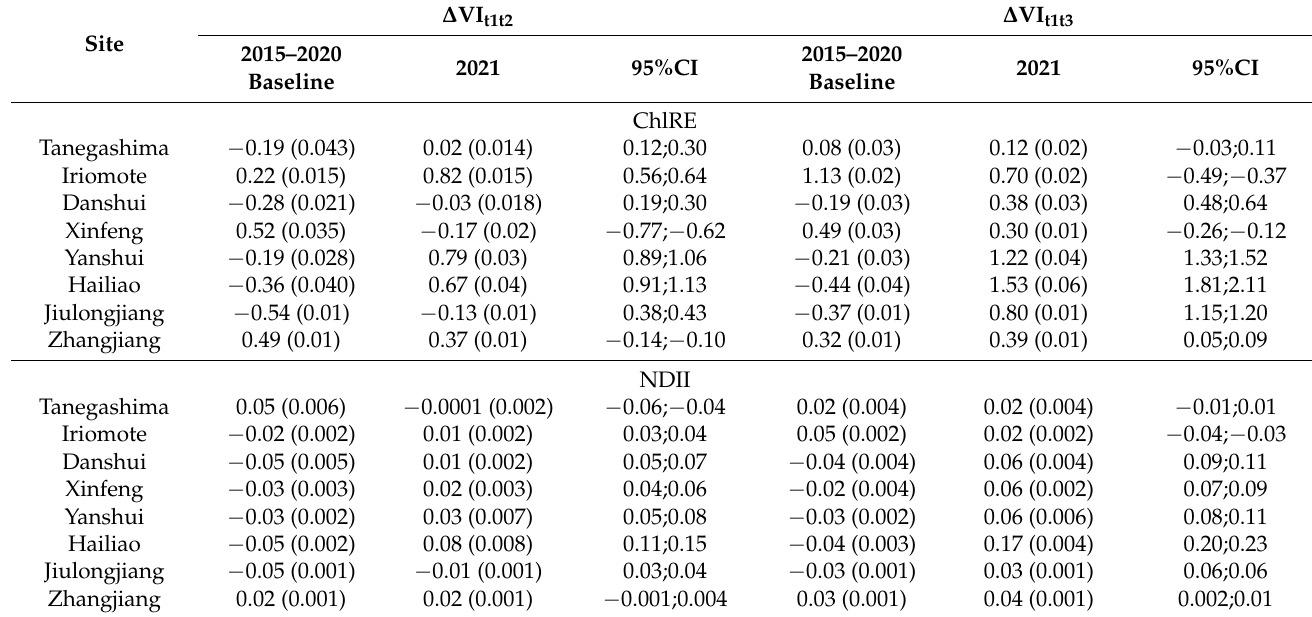
Table 3. Absolute VI change (standard error) for the chlorophyll red-edge index (ChlRE) and normalized difference infrared index (NDII) between t1 and t2 ( ∆ VI t1t2 = VI t1 − VI t2 ) and between t1 and t3 ( ∆ VI t1t3 = VI t1 − VI t3 ) for the 2015–2020 baseline and the cold wave of 2021, where t1 corresponds to the onset of the cold wave (December 16–30), t2 corresponds to the end of the cold wave (January 10–29), and t3 corresponds to the date approximately 30 days after the end of the cold wave (February 07–19). The 95% confidence intervals (95%CI) was calculated using bootstrapped comparisons of means as ∆ VI 2021 − ∆ VI baseline (using 5000 iterations) are also given. Positive 95% CIs, not including zero, show statistically significant decreases in the VI value for the 2021 cold wave relative to the baseline, whereas negative 95% CIs, not including zero, show statistically significant increases in the VI for the 2021 cold wave relative to the baseline.